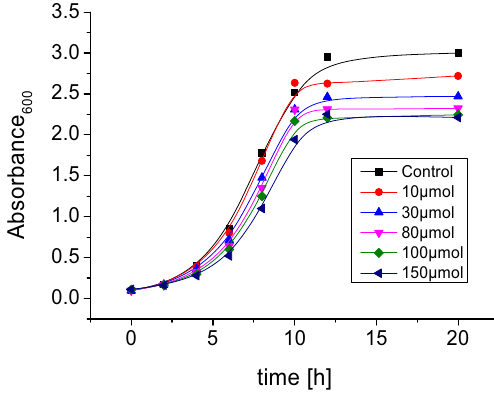
Figure 7: Growth curves of S. cerevisiae during a 24 h cultivation in the presence of 10; 30; 80; 100; and 150 μ M of complex 2